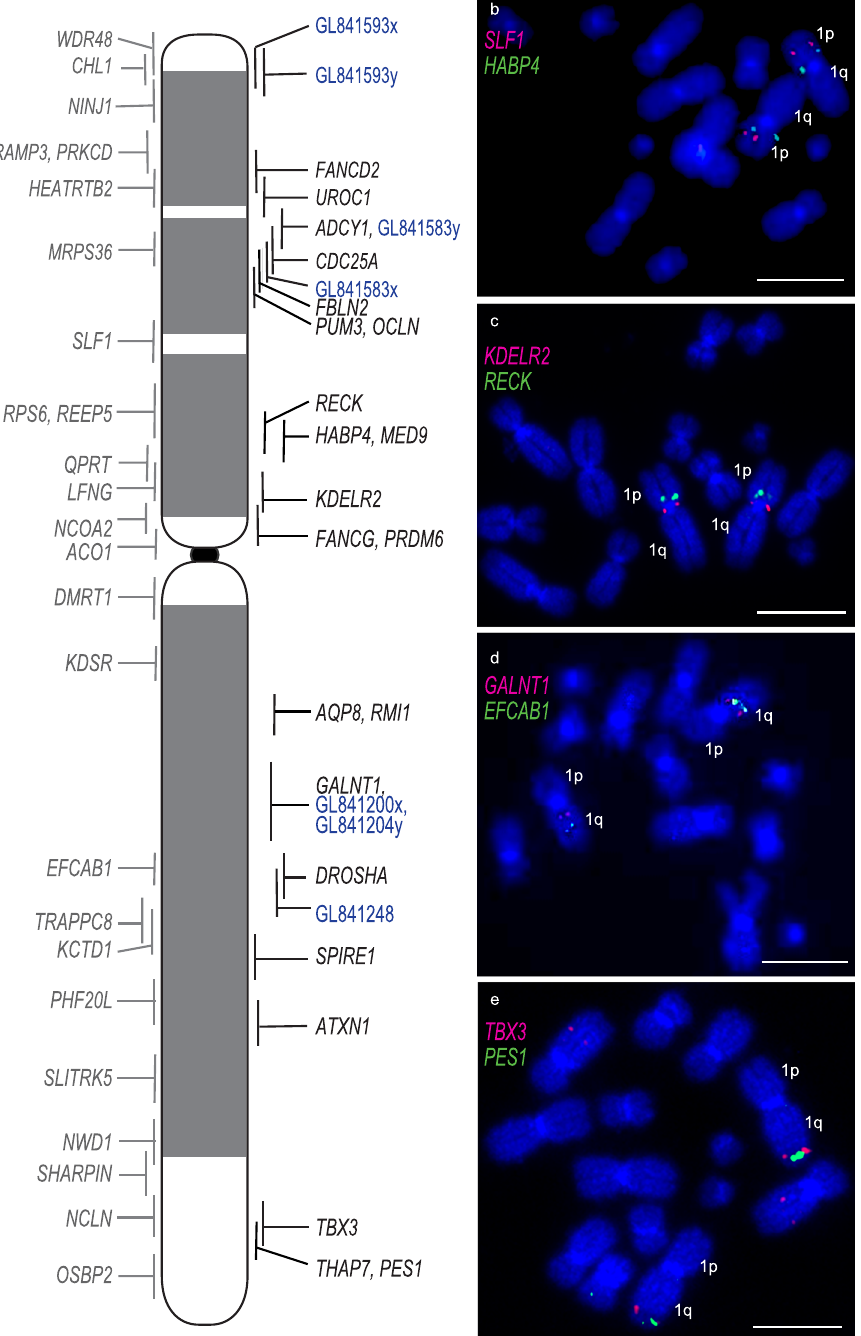
Figure 2. ( a ) Map of normal devil chromosome 1, including genes from the first generation map 13 shown to the left of the chromosome, genes mapped as part of this study and large sequence scaffolds (blue) are shown on the right of the chromosome. Vertical lines indicate the Flpter value ( ± 1 standard deviation). Shading on the devil chromosome corresponds to DAPI banding. ( b – e ) Examples of FISH results for genes mapping close together on chromosome 1. Scale bars represent 10 μ